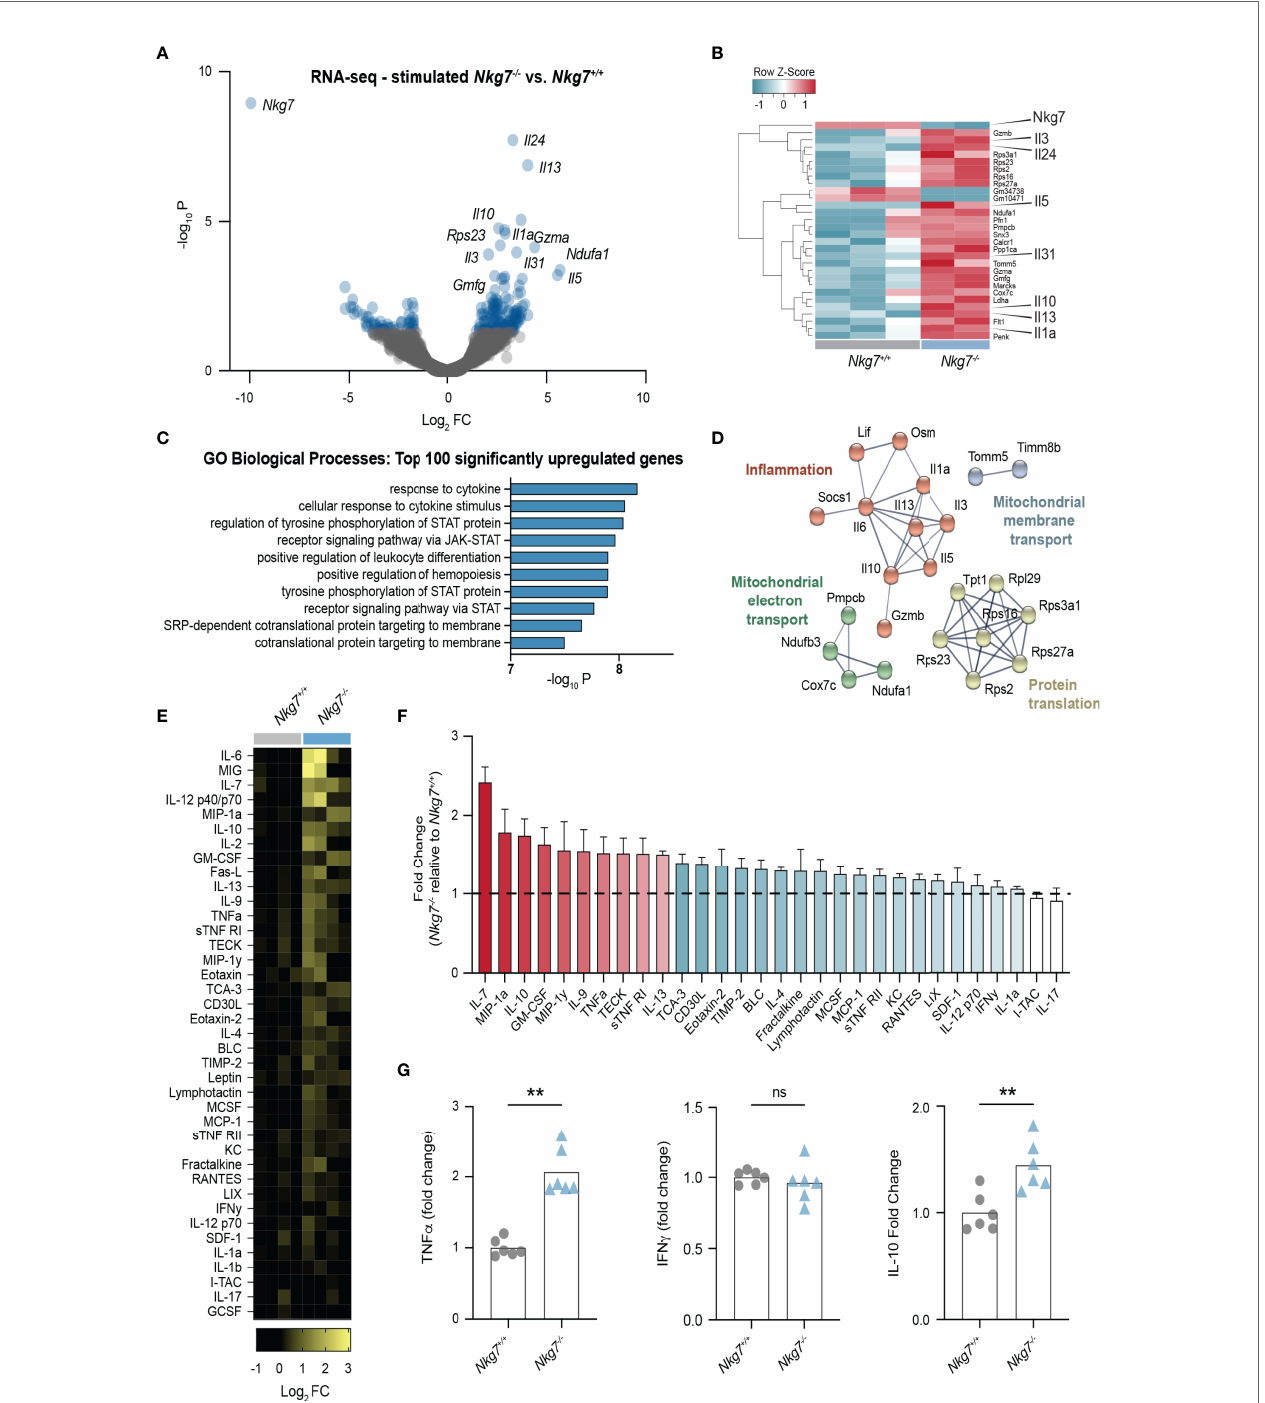
FIGURE 5 | Loss of NKG7 promotes hypersecretion of cytokines following immune synapse formation. (A – D) RNA-sequencing of 72 hour activated Nkg7 -/- and Nkg7 +/+ CD8+ T cells following co-culture with anti-CD3/28-coated P815 cells for 4 hours. (A) Volcano plot of genes up or down regulated in Nkg7 -/- cells compared to Nkg7 +/+ cells, with blue indicating genes with a P-value < 0.05, FC – fold change (B) Heatmap of top 30 differentially expressed genes. (C) Functional Gene Ontology (GO) enrichment analysis of the top 100 differentially upregulated genes. (D) STRING network analysis of top 50 differentially upregulated genes, showing connected nodes only. (E – G) Cytokines secreted by 72 hour activated Nkg7 -/- or Nkg7 +/+ CD8+ T cells co-cultured with anti-CD3/28-coated P815 tumor cells for 4 hours, measured by antibody-pair-based array (E, F) or cytokine bead array (G) using supernatants from co-cultures. (E) Columns represent replicates pooled from 2 independent experiments. (F) Red shows cytokines with average fold change >1.5; blue shows cytokines with average fold change >1, <1.5; error bars show +/- SEM. (G) Unpaired t test, n = 6; ns – not signi fi cant, ** P <